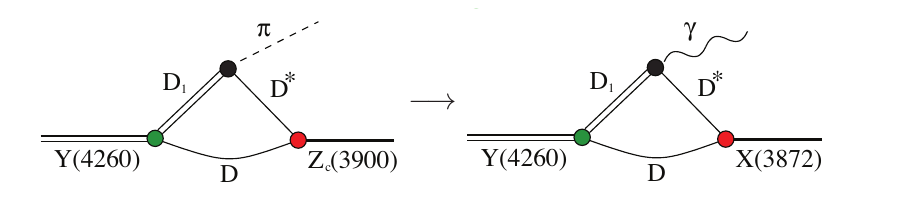
Figure 2. Illustration of the intimate connection between the reactions Y (4260) → π Z c (3900) and Y (4260) → γ X (3872) within the molecular picture for the XYZ